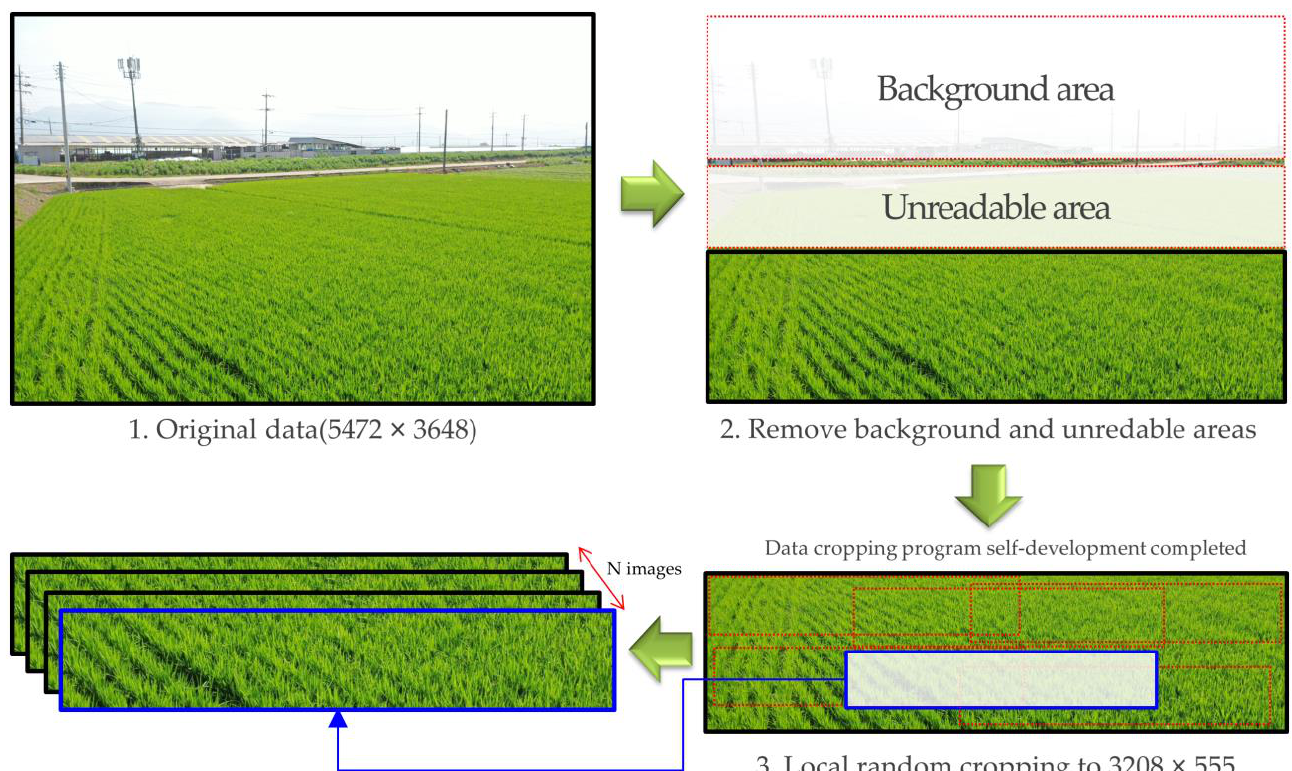
Figure 13. Random cropping procedure from original image.